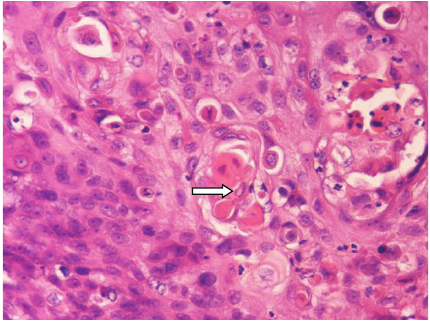
Figure 4: Pathology of the tumour. Thymic squamous cell carci- noma with focal keratinization (arrow): IHC ×